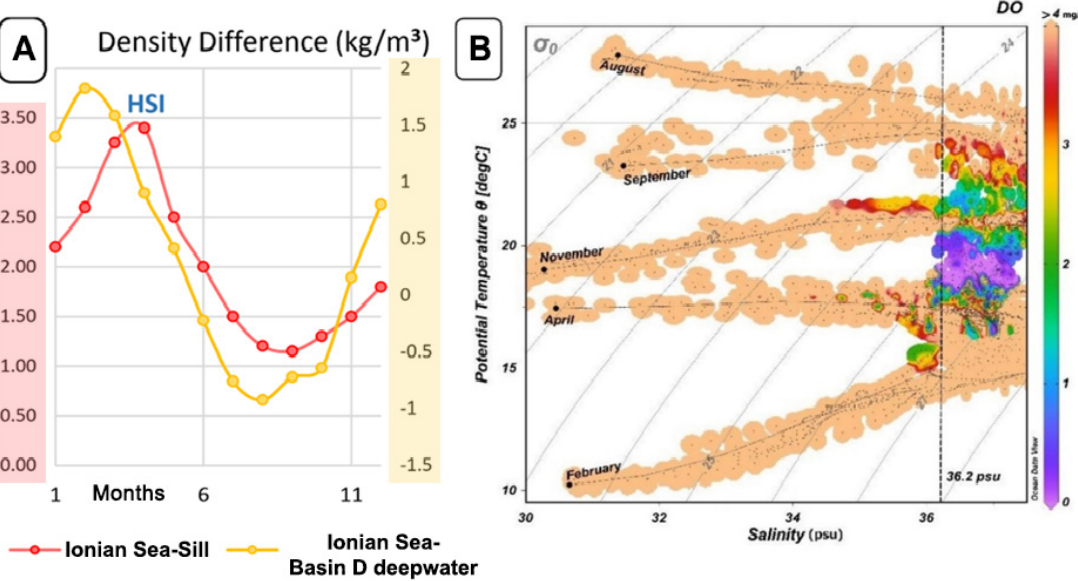
Figure 10. ( A ) Density difference between the Ionian Sea and sill (red line, left axis), ( B ) density difference between the Ionian Sea and the deep water of Basin